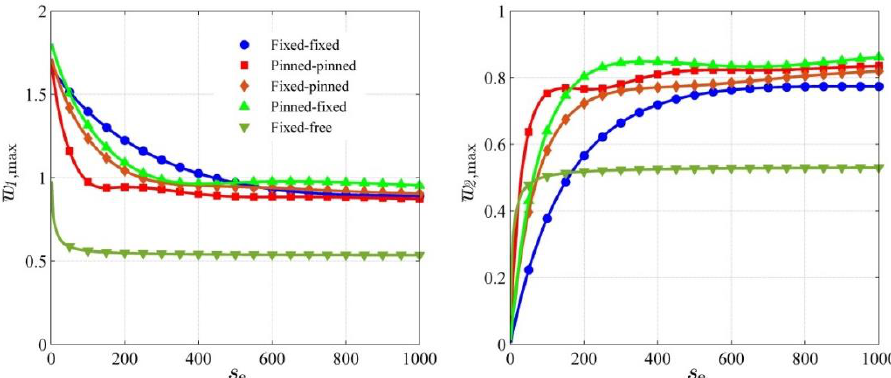
Figure 15. Maximum displacement ratios w 1,max and w 2,max versus contact stiffness ratio s e for different